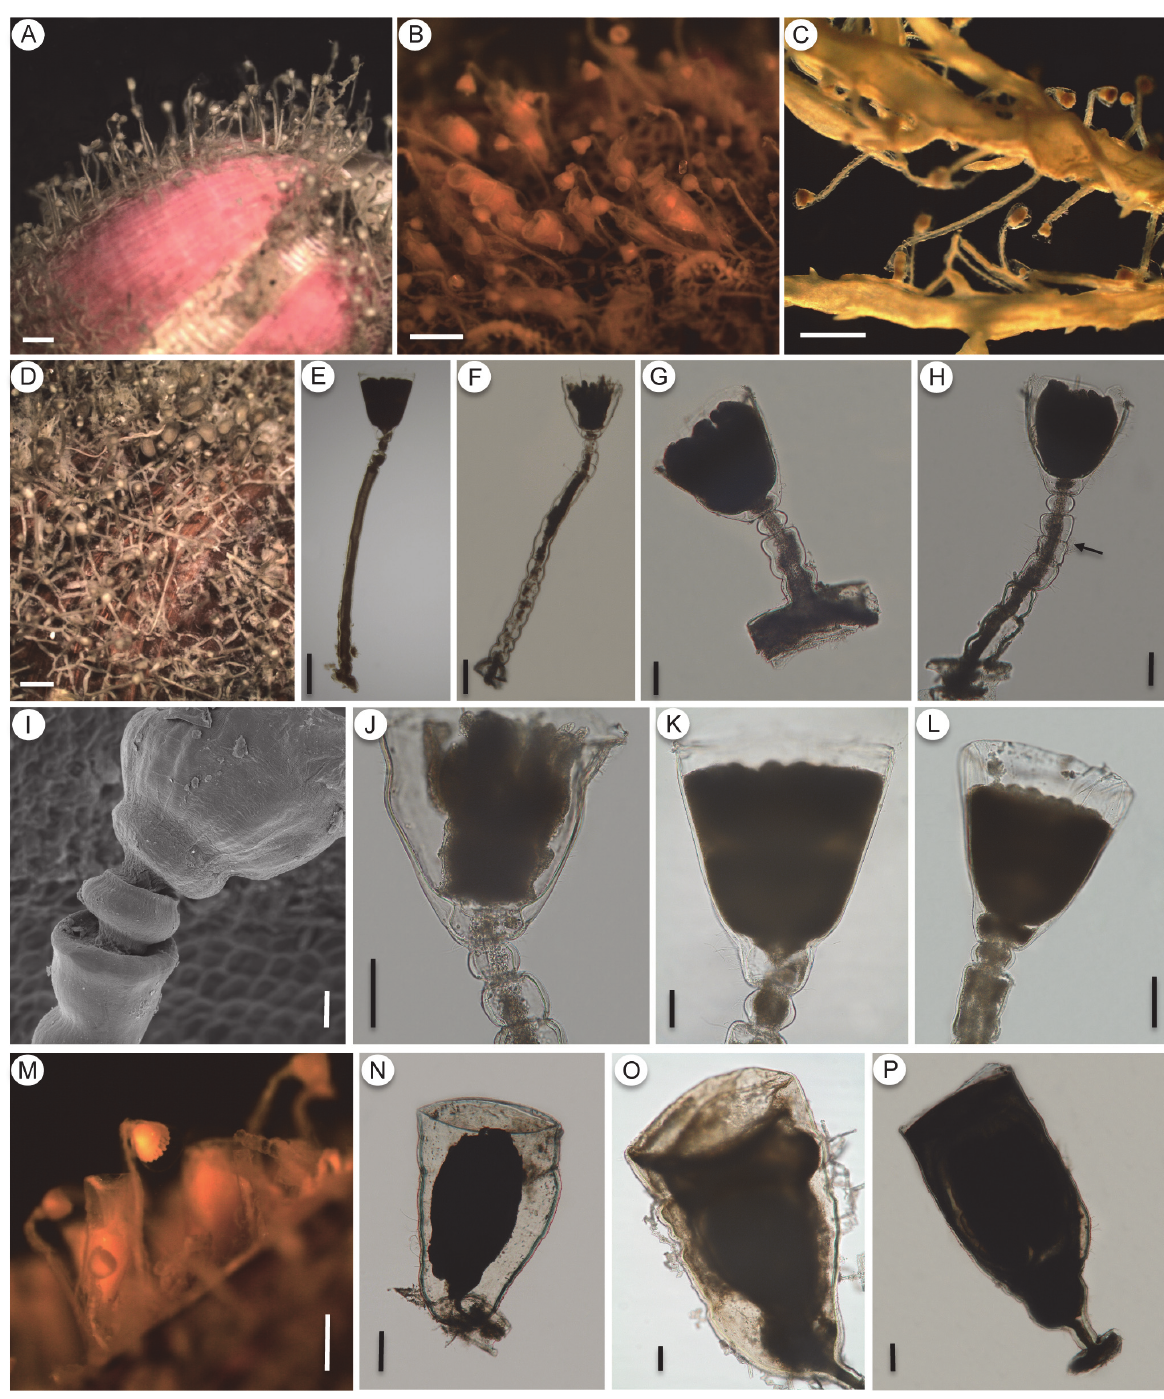
Fig 9. Orthopyxis mianzani sp. nov. A-C: general view of the colony (A-MZUSP 2575; B-MZUSP 2580; C-MZUSP 2559); D: detail of the hydrorhiza (USNM 1259970); E-H: details of the trophosome, showing variation in pedicels from smooth (E) to sinuous (F), variation in the length of the pedicels (compare E, F and G) and constrictions of the perisarc (H, arrow) (E-MZUSP 2576; F-MZUSP 2572; G-MZUSP 2570; H-MZUSP 2574); I: detail of subhydrothecal spherule (USNM 1259970); J-L: detail of hydrothecae (J-MZUSP 2572; K-MZUSP 2576; L-MZUSP 2579); M: general view of the gonotheca on natural substrate (MZUSP 2580); N-P: detail of female gonothecae (N-MZUSP 2572; O-USNM 1259970; P-MZUSP 2580). Scales: A-D — 1 mm; E — 300 μ m; F, N, P — 200 μ m; G, H, J-L, O — 100 μ m; I — 20 μ m; M — 500 μ m.